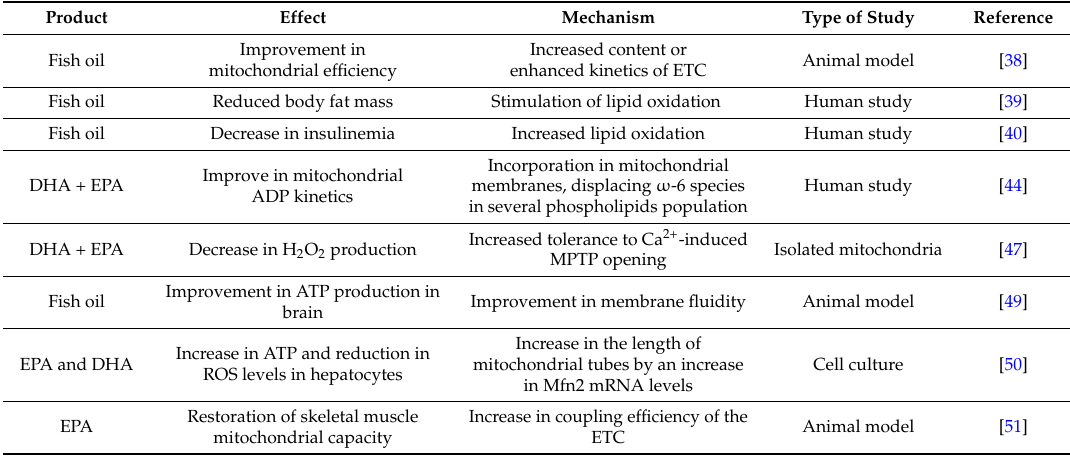
Table 2. Described effects of dietary phenolic compounds in mitochondria and metabolic